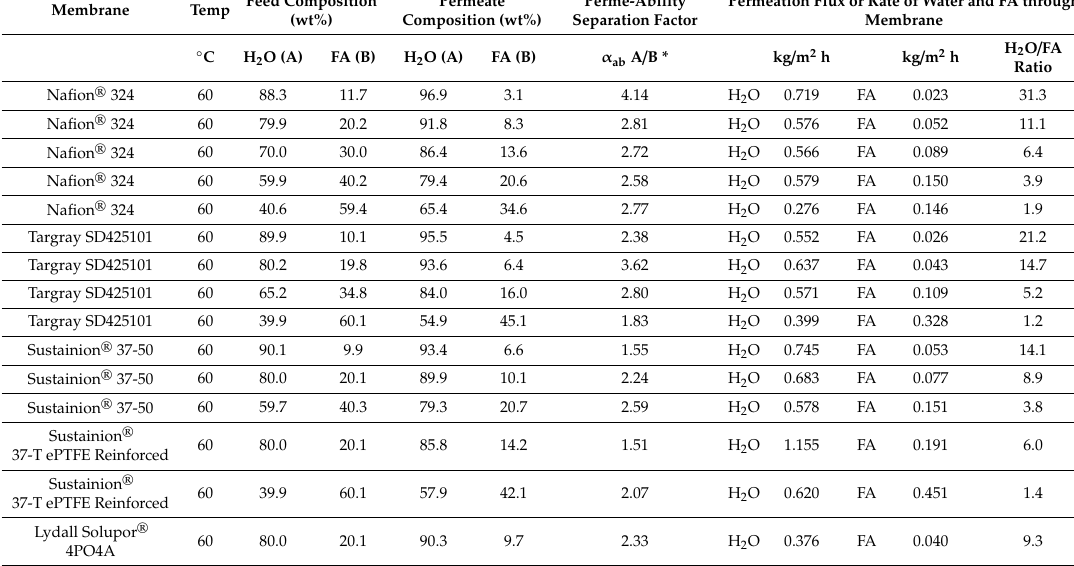
Table 4. Pervaporation data summary (in a shorter tabulated form) for the various membranes at a fixed temperature of 60 ◦ C and for FA feed concentrations ranging from 10 to 60